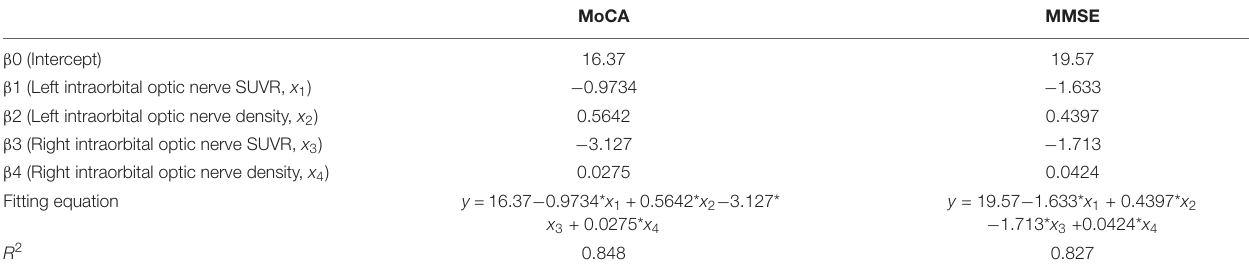
TABLE 7 | Results of multiple linear regression.